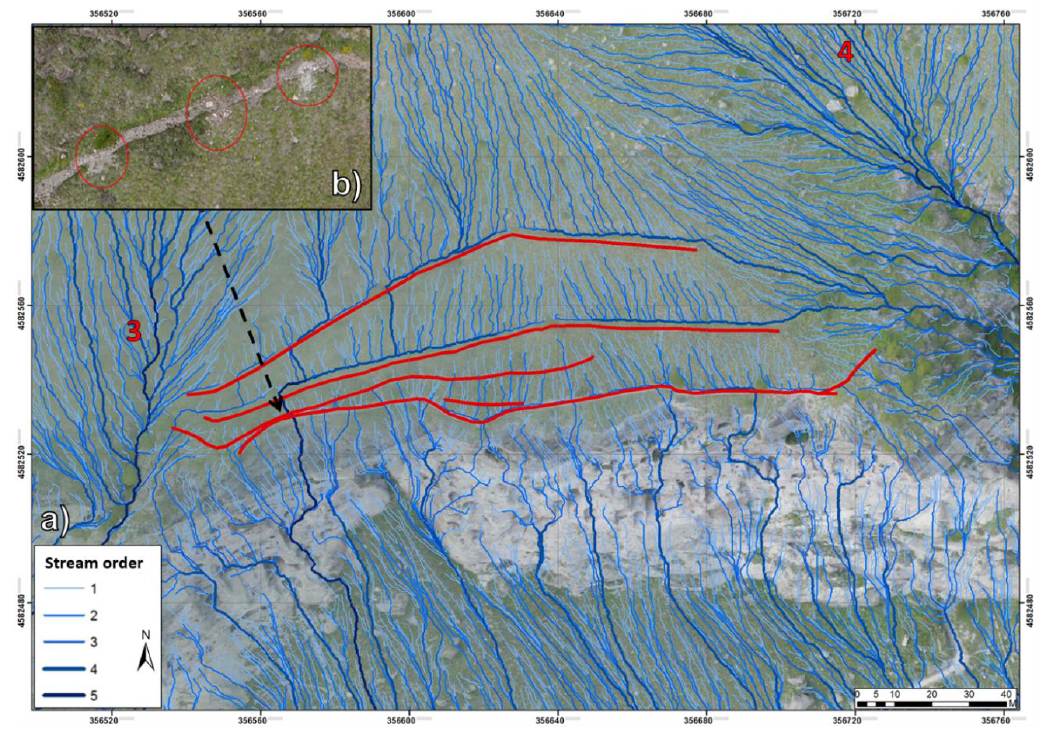
Figure 11. UAV-DP products: ( a ) 2D Orthoprojection of Vardzia’s hydrographic network on the Upper slope sector and cliff face, ( b ) detail of runnel-retaining wall sector impacted by boulders.